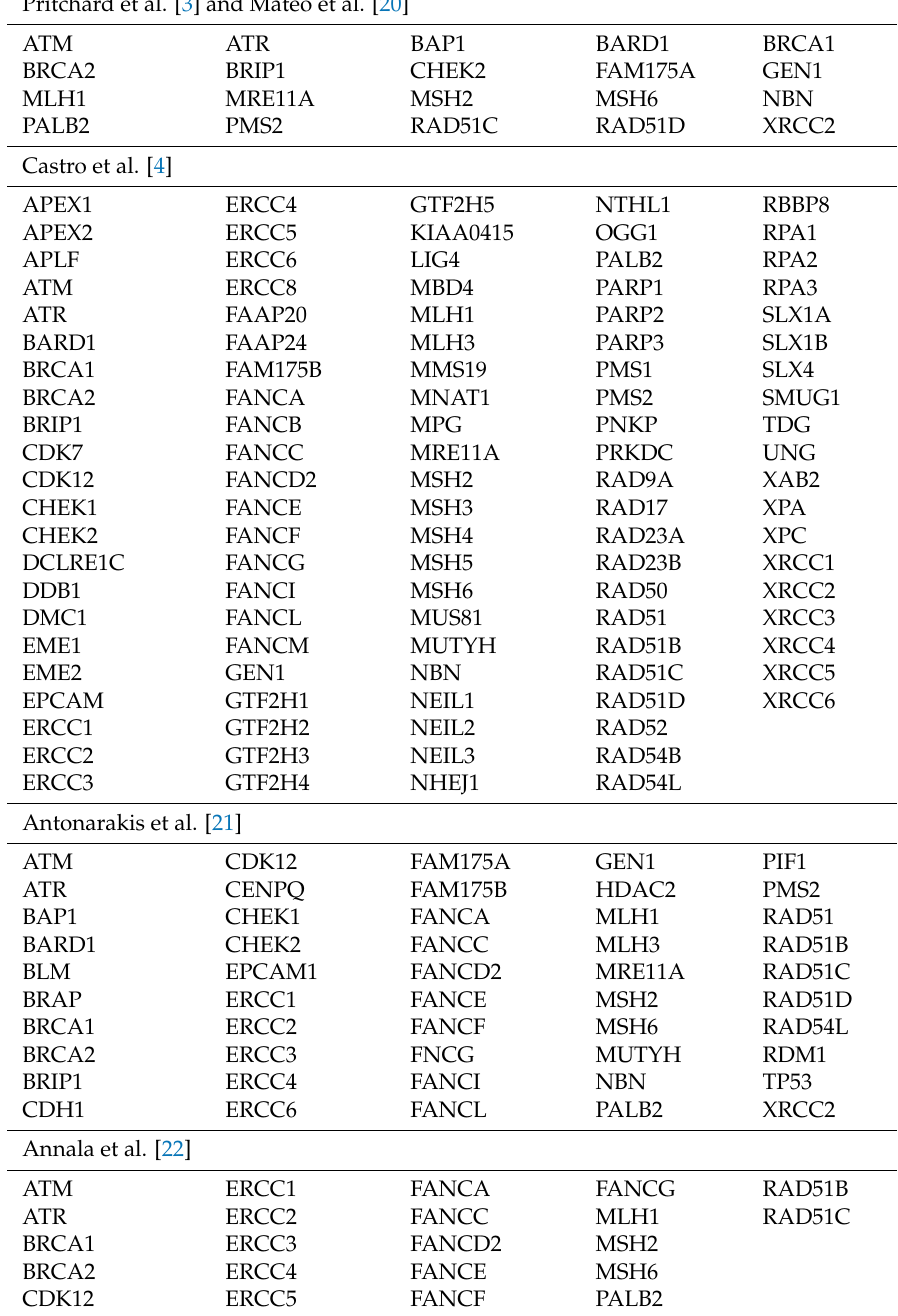
Table 1. DDR genes screened for germline mutations in mCRPC studies mentioned in this review. Pritchard et al. [3] and Mateo et al.